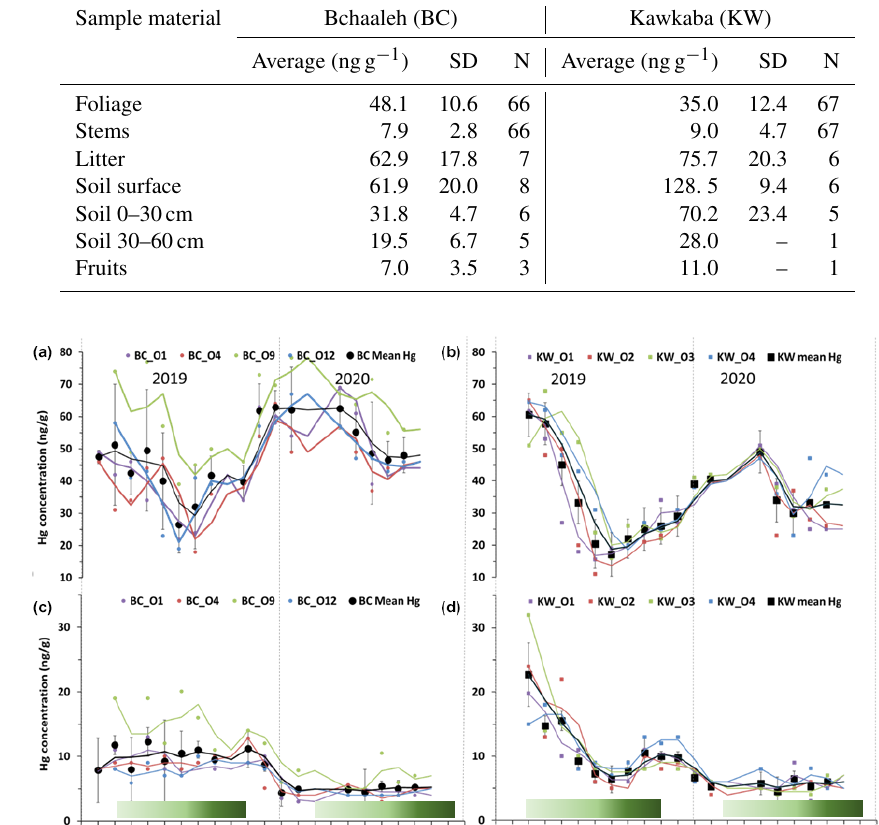
tration of plant tissues. Our values are lower than 200 ng g − 1